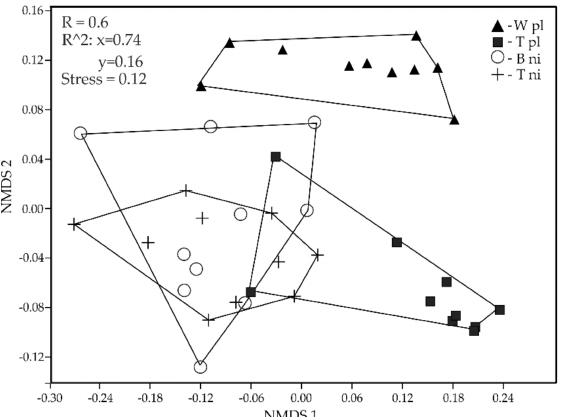
Figure 2. Diagram of non-metric multidimensional scaling (NMDS) performed using the Bray-Curtis similarity matrix of spiders assemblages (B ni-non-inversion barley; T pl-ploughed triticale, W pl-ploughed wheat, T ni-non-inversion